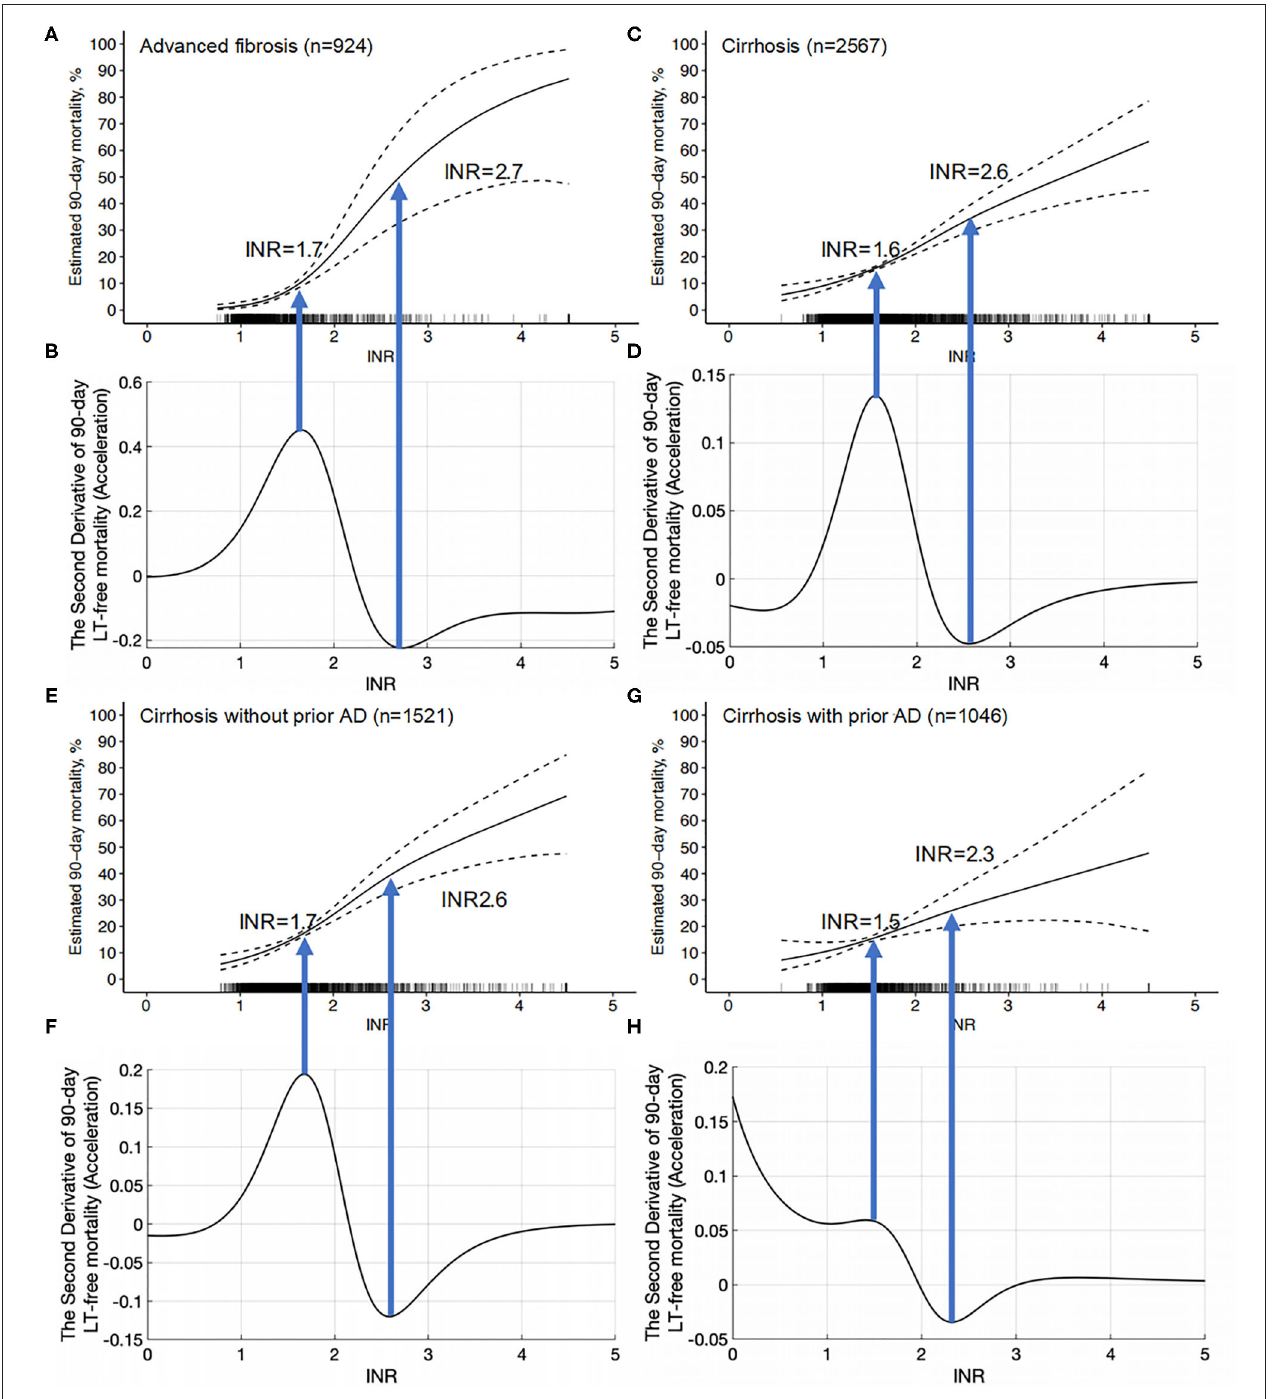
FIGURE 5 | The INR-mortality (90-day) correlation curves and their corresponding second derivative (acceleration) curves. (A) The INR-mortality (90-day) correlation curve of advanced fibrosis, (B) the second derivative (acceleration) of INR to mortality in advanced fibrosis, (C) the INR-mortality (90-day) correlation curve of cirrhosis, (D) the second derivative (acceleration) of INR to mortality in cirrhosis, (E) the INR-mortality (90-day) correlation curve of cirrhosis without prior AD, (F) the second derivative (acceleration) of INR to mortality in cirrhosis without prior AD, (G) the INR-mortality (90-day) correlation curve of cirrhosis with prior AD, and (H) the second derivative (acceleration) of INR to mortality in cirrhosis with prior